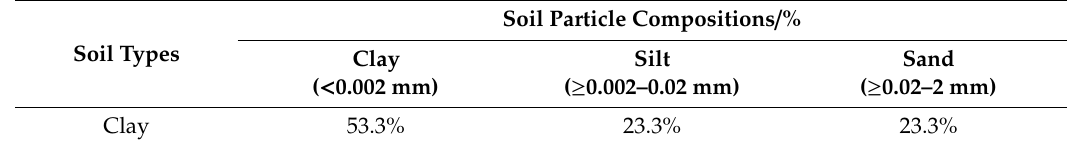
Table 5. Physical properties of